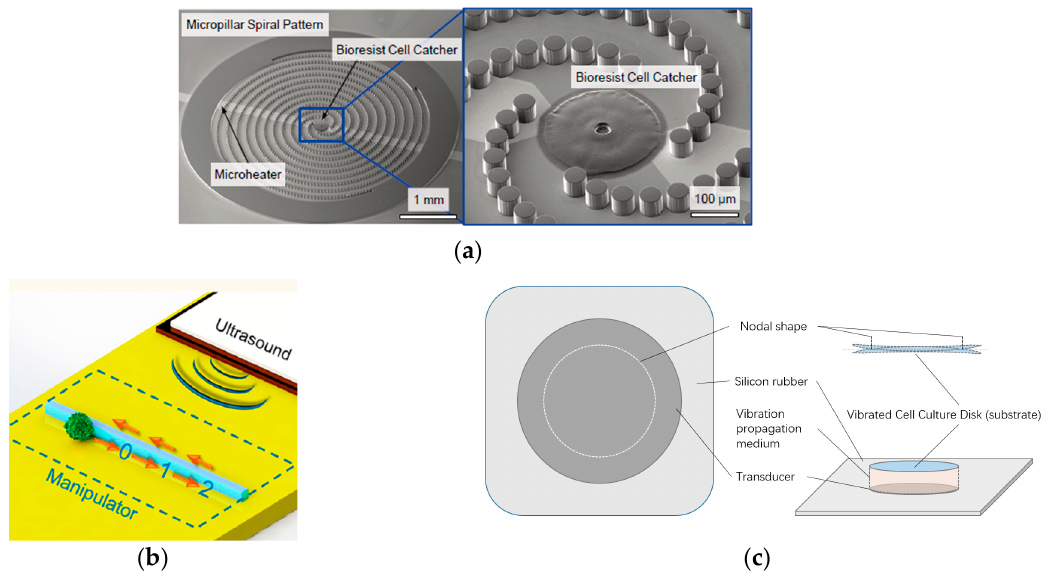
Figure 6. Vibrated geometric substrates by Hayakawa et al. [69,70] , Lu et al. [71] , and Imashiro et al.